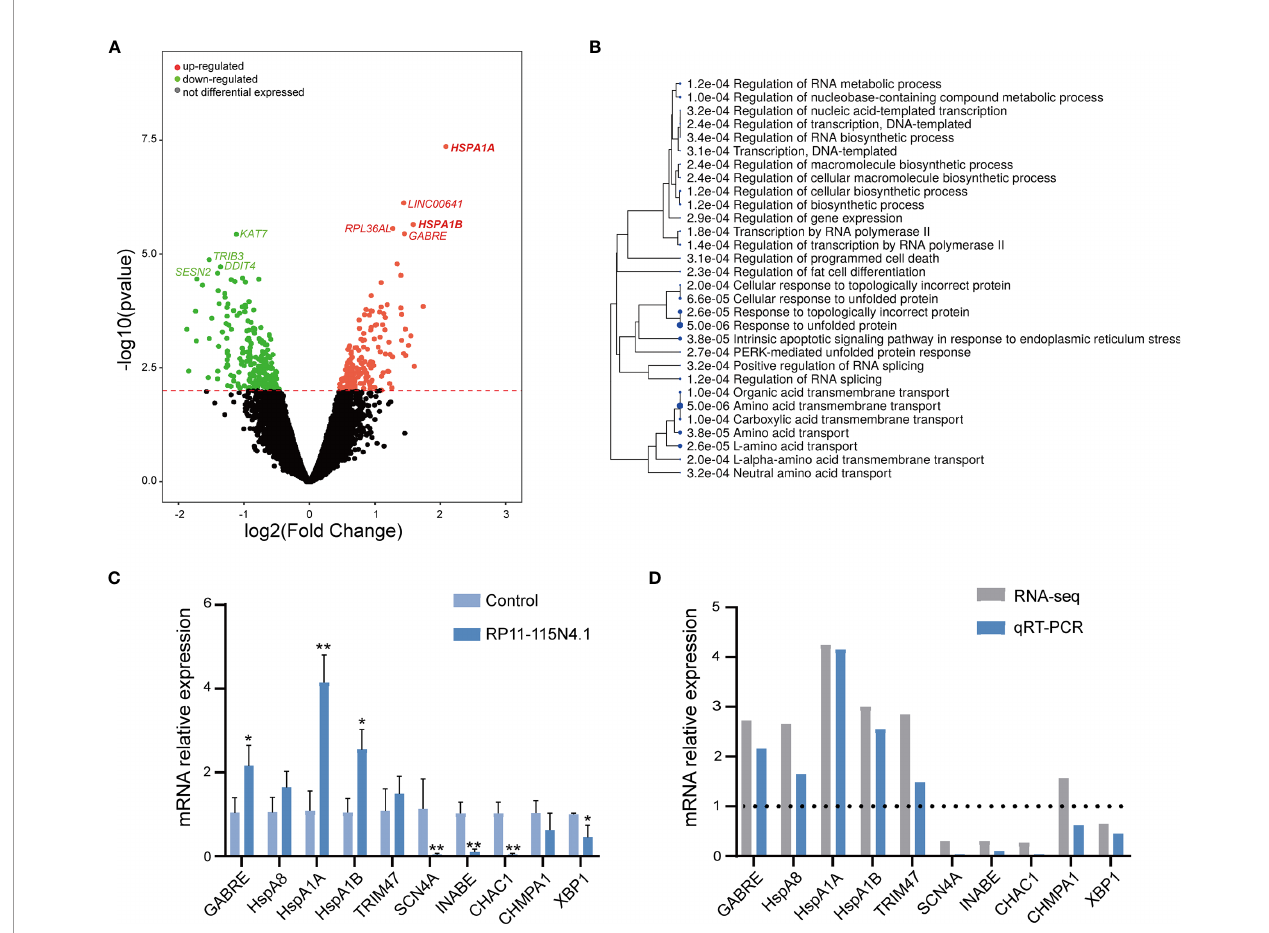
FIGURE 3 | RP11-115N4.1 promoted HSP70 transcription. (A) Volcano plot described that the differentially expressed mRNAs in K562 cells with RP11-115N4.1 overexpression. (B) GO analysis data described that the differentially expressed mRNAs in K562 cells with RP11-115N4.1 overexpression. (C, D) Validation of differentially expressed genes by qRT-PCR. * P < 0.05, ** P < 0.01. Each experiment was repeated three times and results are means ±